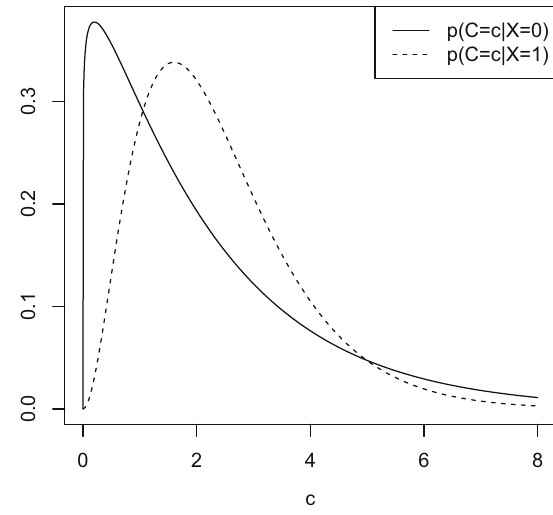
Figure 5: Gamma distributions with l